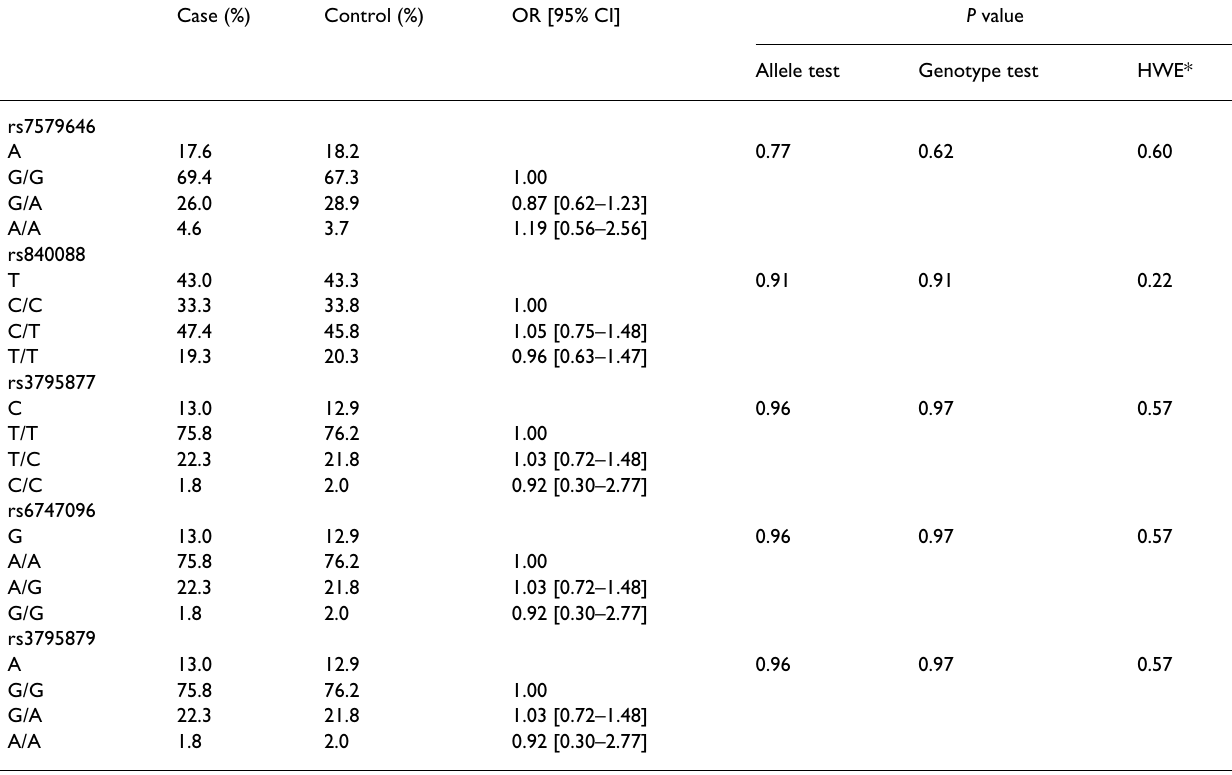
Table 2: Genotypes and alleles distribution in patients with COPD and healthy